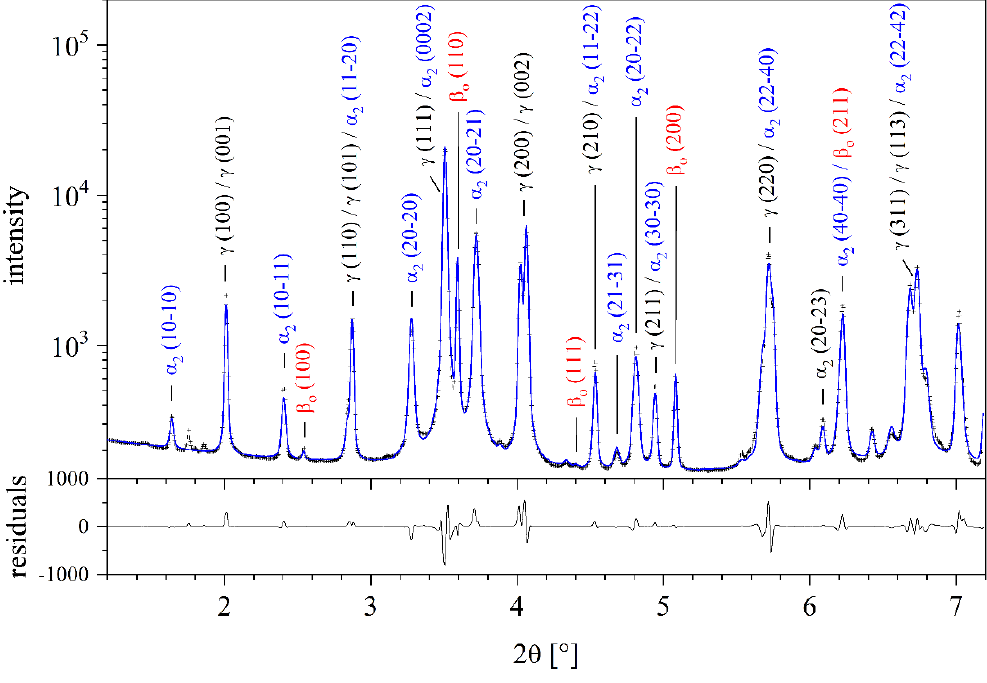
Figure 3. 90° sectors of detector images at three different temperatures during heating with 20 K min –1 (see text). The development of grain size and texture can be visualized by plotting the intensity of a single peak as a function of azimuth angle and time or temperature. In Figure 4, one relevant peak of each phase is plotted as a function of temperature in an azimuthal range from 0° to 90°. At lower temperatures, the intensity modulations in azimuthal direction